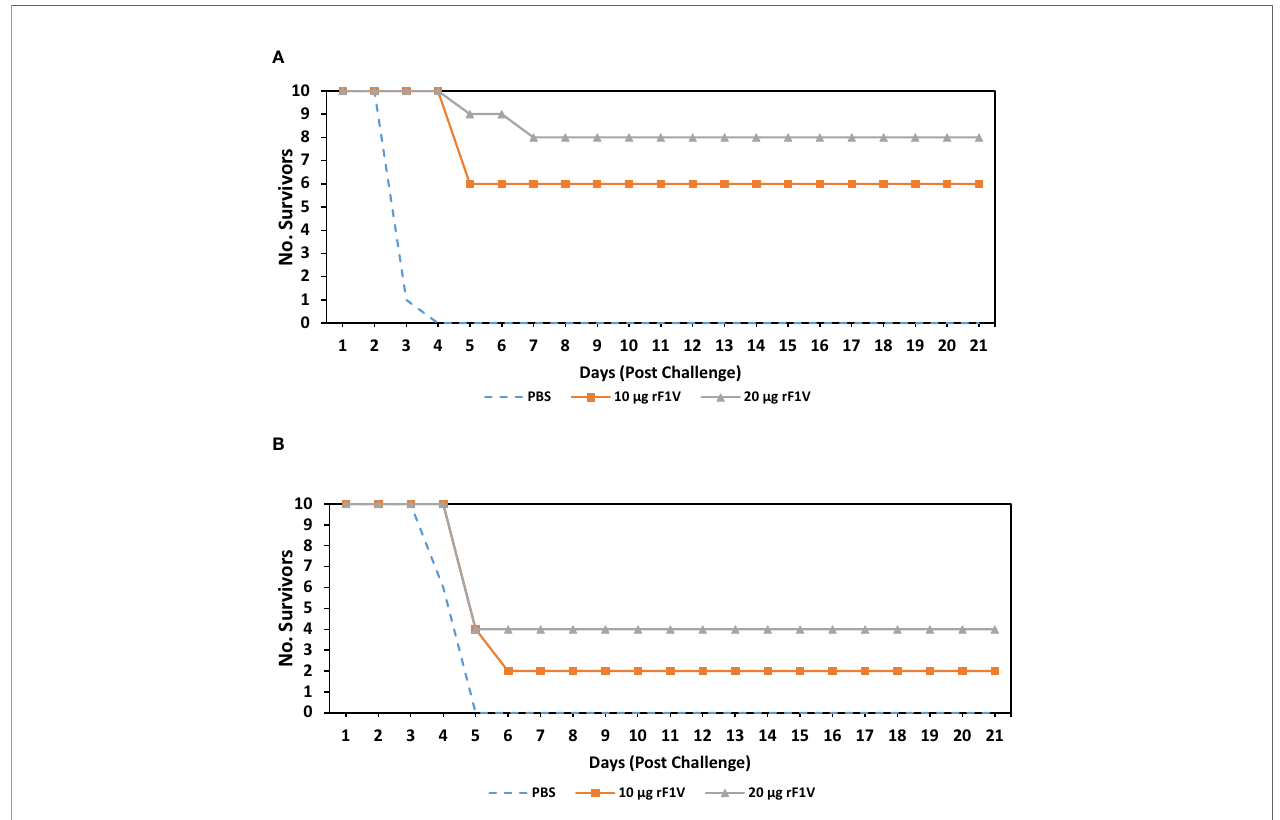
FIGURE 2 | BALB/c mice vaccinated with rF1V are more susceptible to non-encapsulated Y. pestis C12 strain. BALB/c mice were vaccinated once, subcutaneously, with mock/PBS, 10 µg or 20 µg of rF1V (n=10). At 29 days post vaccination, BALB/c mice were exposed to aerosolized bacteria with (A) 2.63x10 6 CFU of Y. pestis CO92 (approximately 39 LD 50 equivalents) or (B) 2.31x10 6 CFU of Y. pestis C12 (approximately 30 LD 50 equivalents), respectively. Survival was monitored for 21 days post